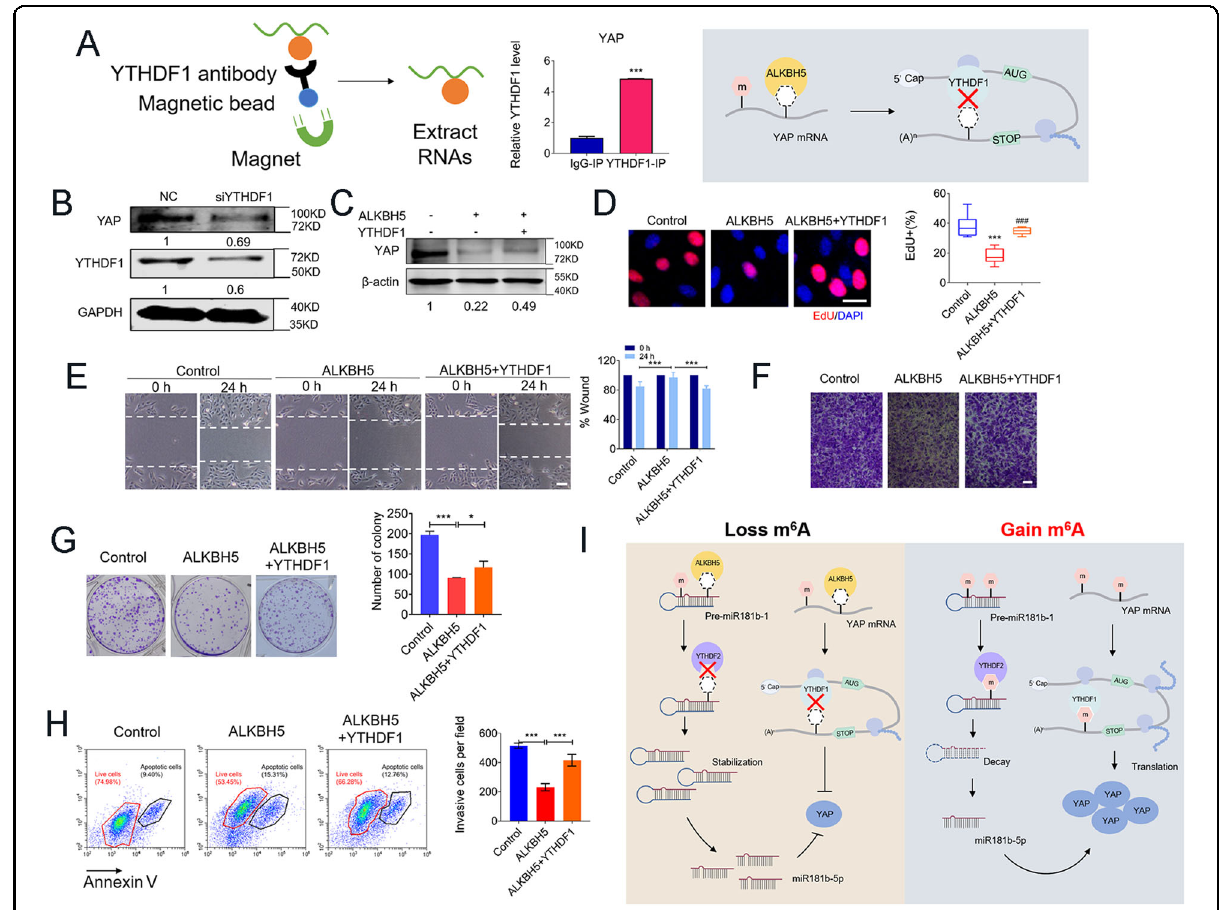
Fig. 8 m 6 A-dependent translational enhancement of YAP is positively associated with YTHDF1. A RIP-qPCR analysis of the interaction between YAP with YTHDF1 in U2OS cells (left, n = 3). Diagram illustrating YTHDF1 replace ALKBH5 binding to YAP (right). B YTHDF1 knockdown impairs the translation of YAP. C YTHDF1 overexpression reverses the decrease of YAP caused by ALKBH5 tested via western blot. D EdU staining showing the reversing effects of YTHDF1 on proliferation inhibition of ALKBH5 overexpression (Bar: 25 μ m, n = 5). E Cell invasion ability analyzed by migration assays at 24 h after forced expression of ALKBH5 or co-transfected with YTHDF1 plasmids. F The effects of YTHDF1 on the weakening of ALKBH5 anti-invasion ability detected by Transwell assay (Bar: 150 μ m, n = 5). G Representative images of colony-formation cells ( n = 3). H Annexin V/ PI staining of U2OS cells analyzed by FACS. I Graphic abstract of ALKBH5 regulates the progression of osteosarcoma by mediating m 6 A modi fi cation of pre-miR-181b-1 and YAP. Data are expressed as mean ± SEM. * P < 0.05, *** P < 0.001 (vs. the fi rst group). ### P < 0.001 (vs. the second